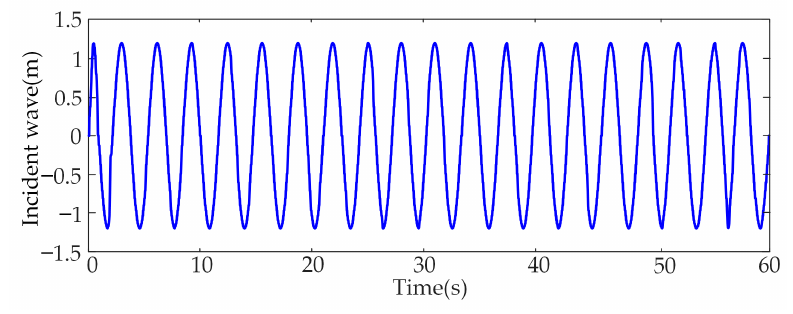
Figure 5. Regular incident waves.